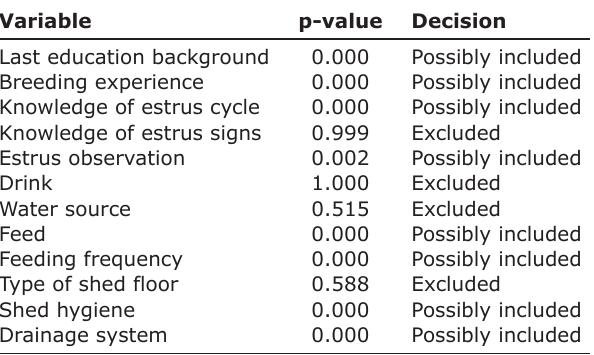
Table-6: Multiple logistics regression analysis of risk factors for repeat breeding in beef cattle in Sleman Regency,